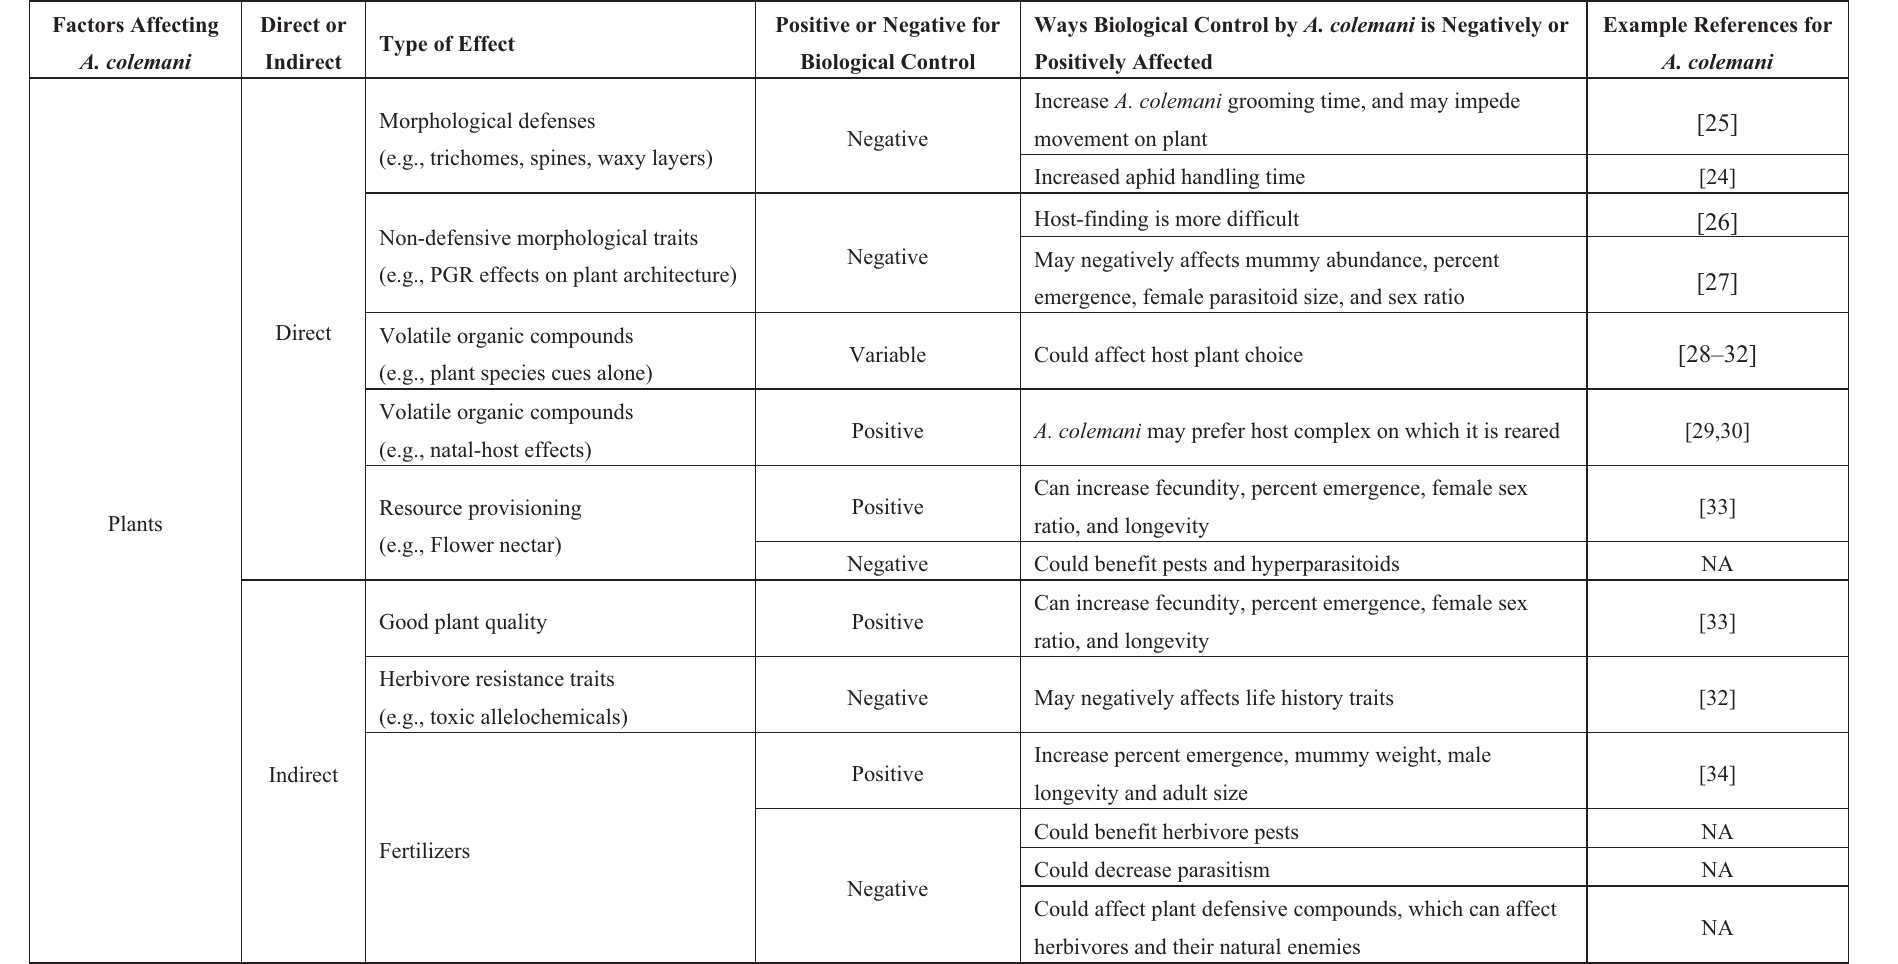
Table 1. List of ecological factors in greenhouse crops that can directly and indirectly affect the efficacy of A. colemani , with gaps in research for this species